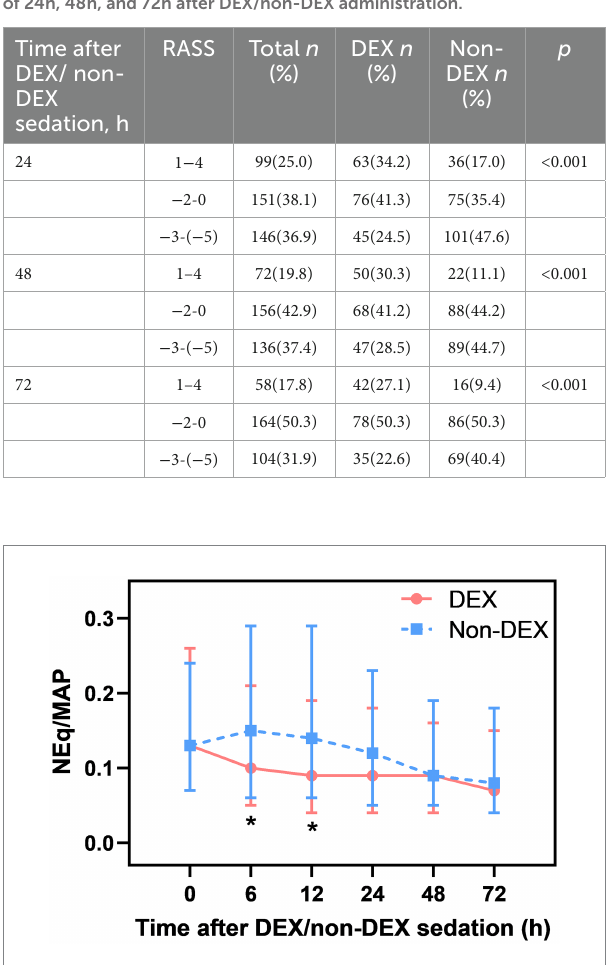
FIGURE 2 The effect of DEX/non-DEX administration on NEq/MAP ( p <